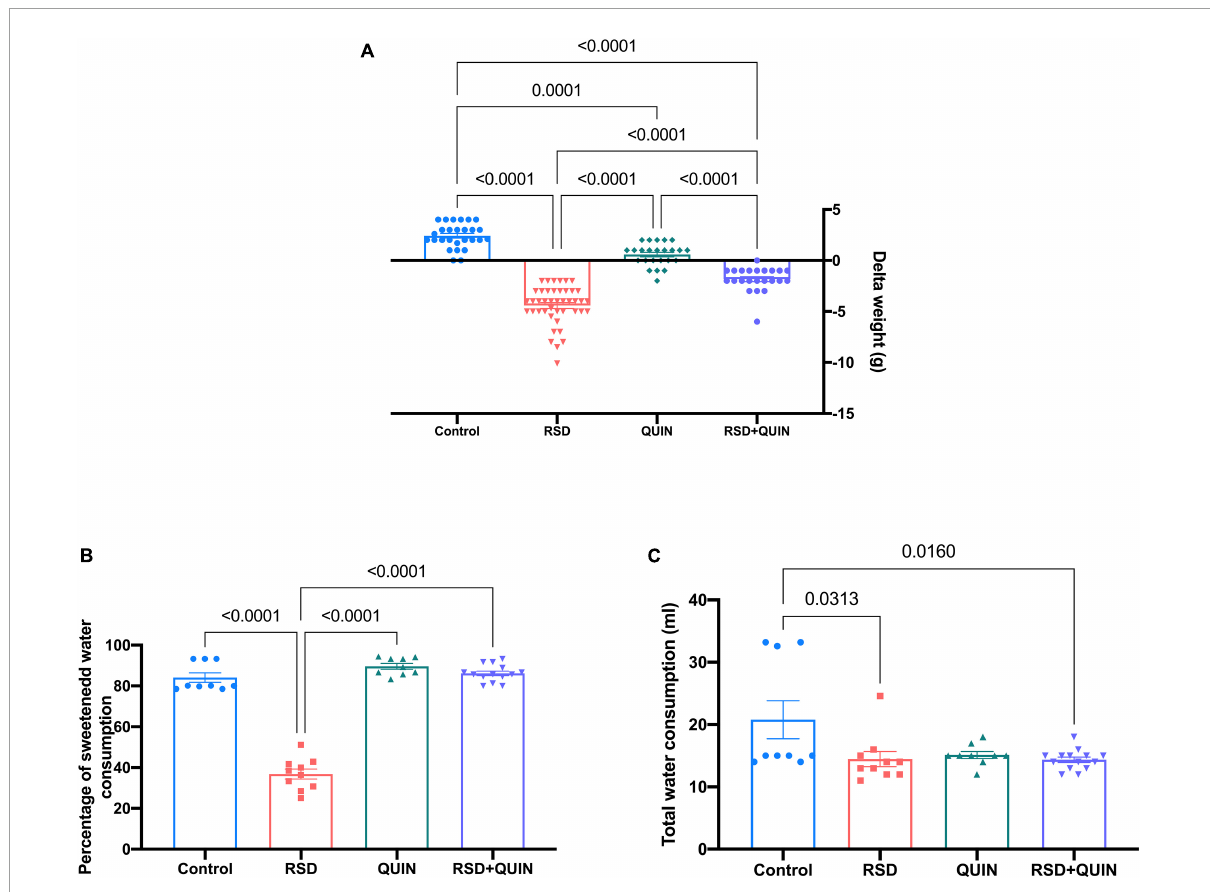
FIGURE6 Body weight and sucrose water consumption decreased after REM sleep deprivation (RSD), whereas Quinpirole (QUIN) administration attenuated these changes. Mice were administered with QUIN (2 mg/kg for 3 days) and exposed to RSD. Delta of body weight (A) , sucrose water consumption (B) , and total water consumption (C) . Data are presented as the mean ± SEM and were analyzed using one-way ANOVA, followed by Tukey’s post-hoc test. Body weight measurements: Control n = 27, QUIN n = 24, RSD n = 43, RSD + QUIN n = 23. Sucrose water consumption: Control n = 9, QUIN n = 9, RSD n = 10, RSD + QUIN n = 14. Significant differences among the experimental groups are